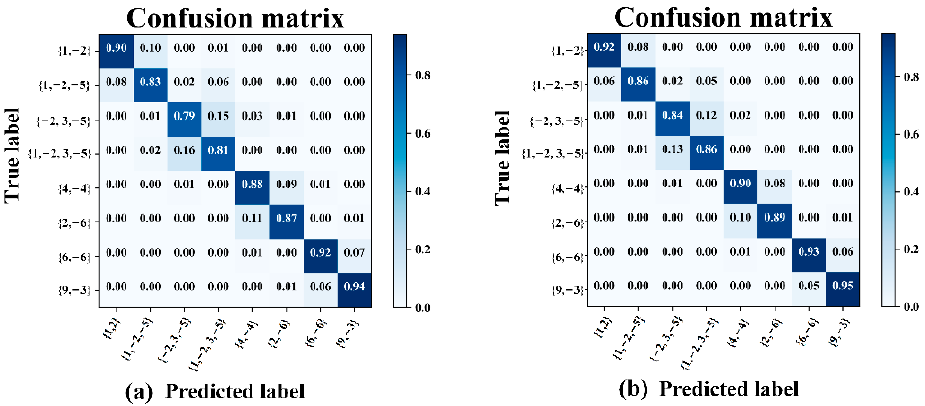
Figure 9. Confusion matrix ( a ) by ResNet18 ( b ) by AP-CNN.